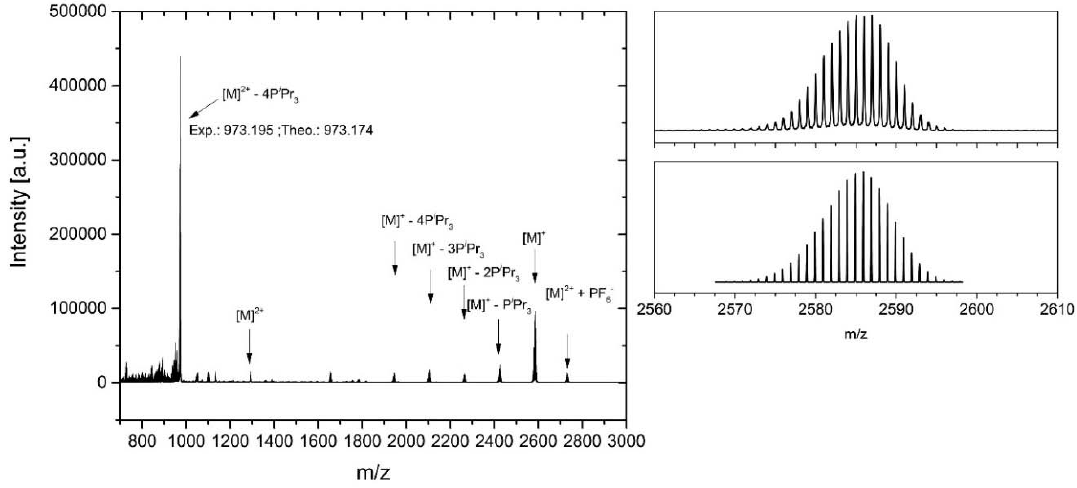
Figure 3. ( Left ): HR ESI Mass spectrum of macrocycle 3 ; ( right ): experimental ( top ) and simulated ( bottom ) isotope peak pattern for the [M + ] peak.